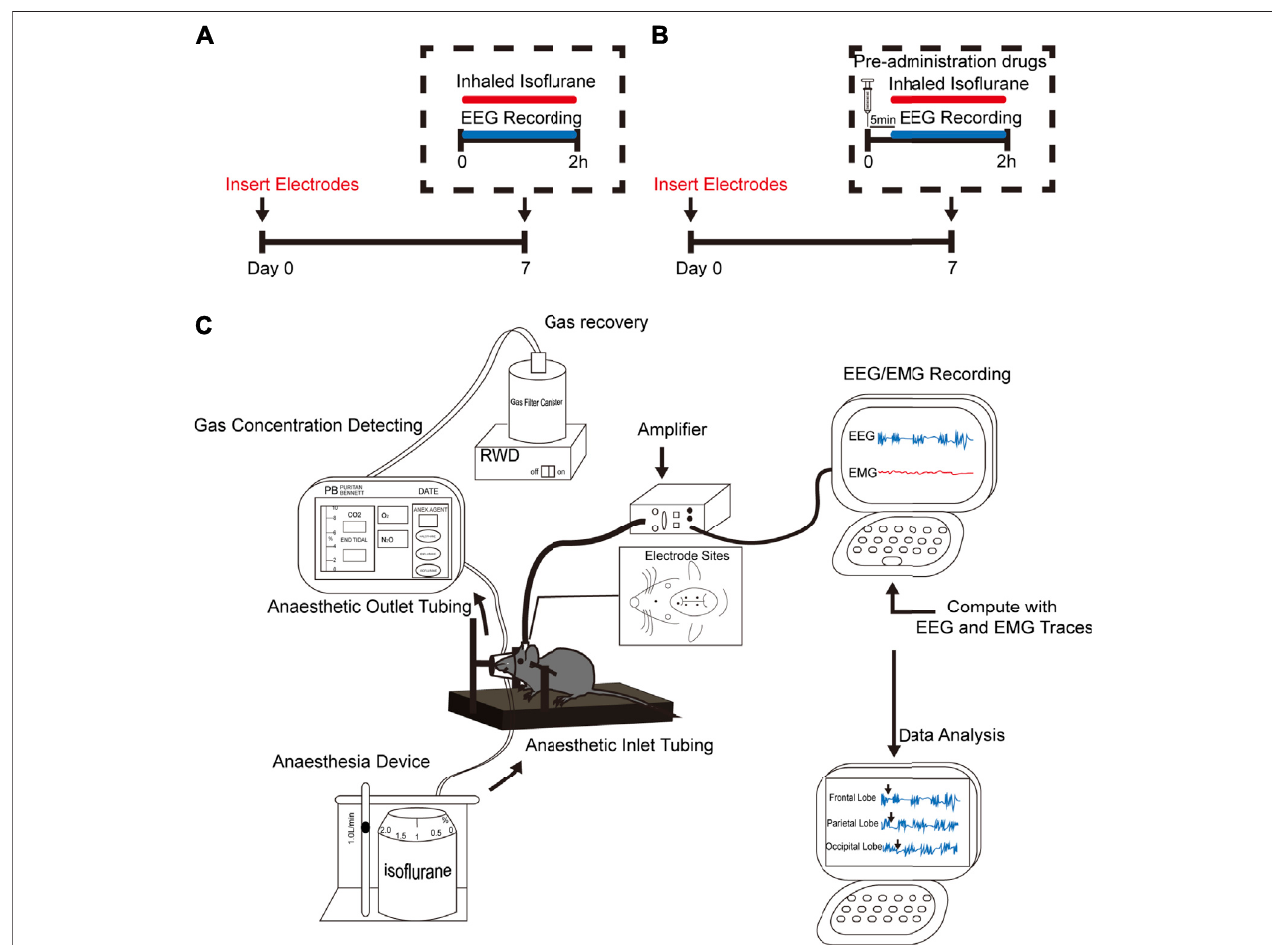
FIGURE 1 | Experimental design. (A,B) Schematic timelines illustrating the procedure performed for each experimental animal in this study. The timelines indicate that all animals underwent head-cap surgery 1 week before the experiment. (A) Animals only received iso fl urane anesthesia. (B) Animals received co-administered anesthetics or adjuvant drugs are given 5 min in advance. Throughout the entire experiment, EEG and electromyography (EMG) were performed. (C) Schematic shows anesthetic inhalation, EEG/EMG recordings, and data analysis systems. The concentration of administered gas was monitored continuously to ensure the stability of the experimental